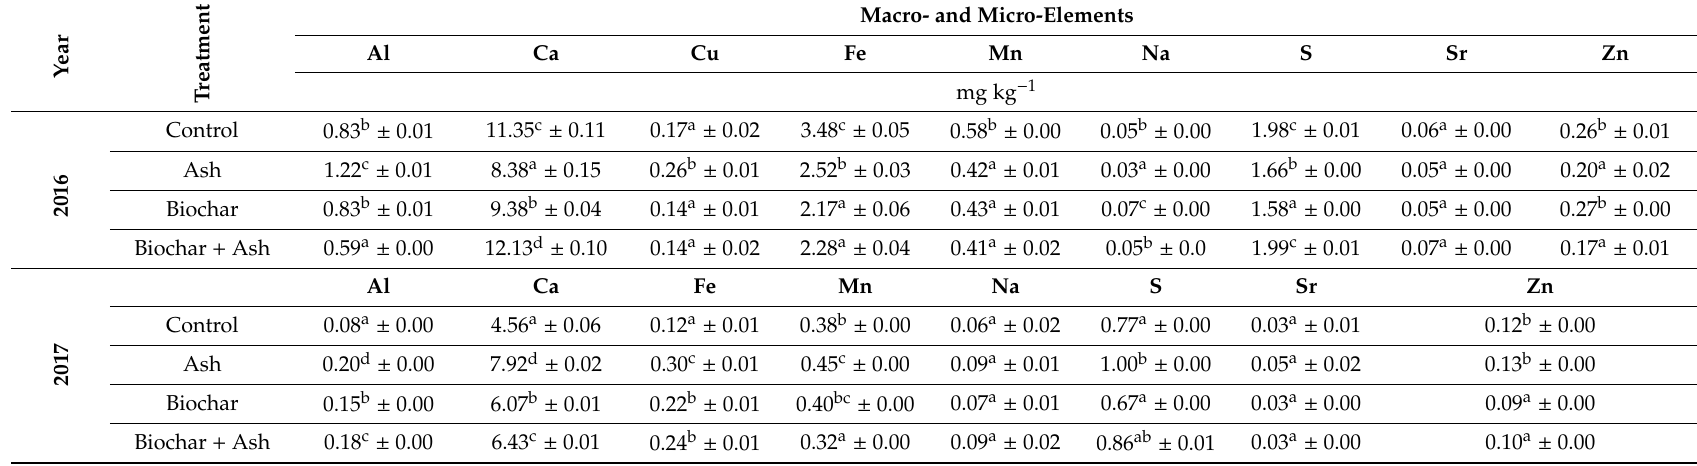
Table 4. Mean concentration of selected macro- and micro-elements as well as heavy metals ( ± SD) in the pyrolysates produced from giant miscanthus biomass, in the first and the second year of the study, relative to the treatment applied ( n =